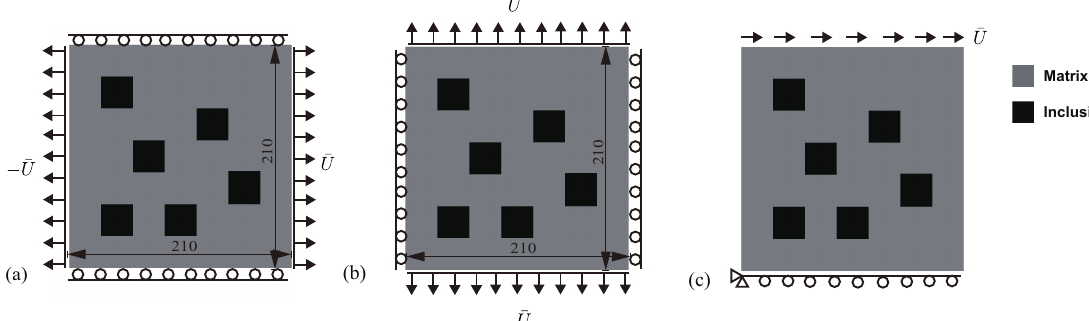
Figure 14. Unit cell of a material containing square inclusions randomly distributed: ( a ) geometry of the initial design and load case 1; ( b ) load case 2; ( c ) load case